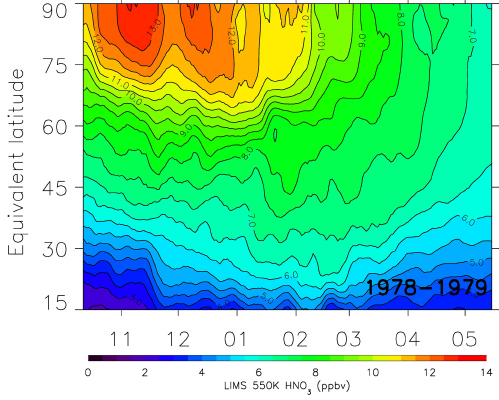
Figure 17. As in Fig. 16, but for HNO 3 (CI is 0.5ppbv).